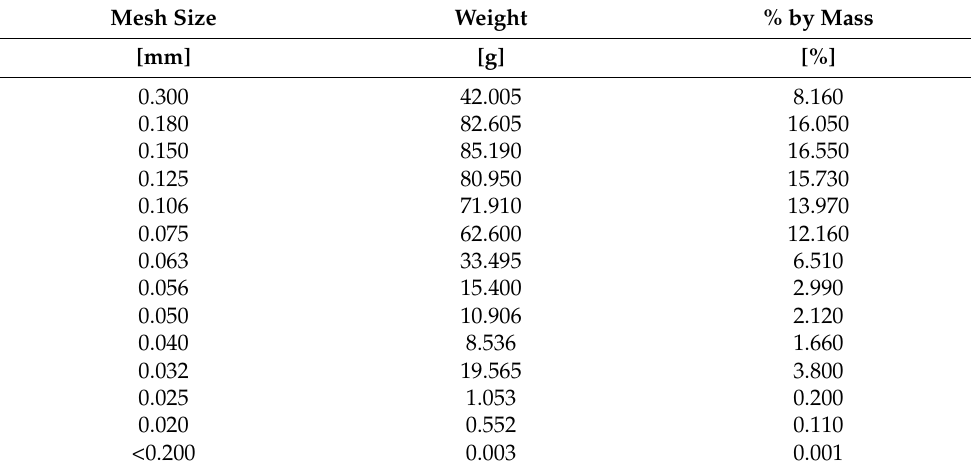
Table 2. Results of granulometric analysis for basalt dust